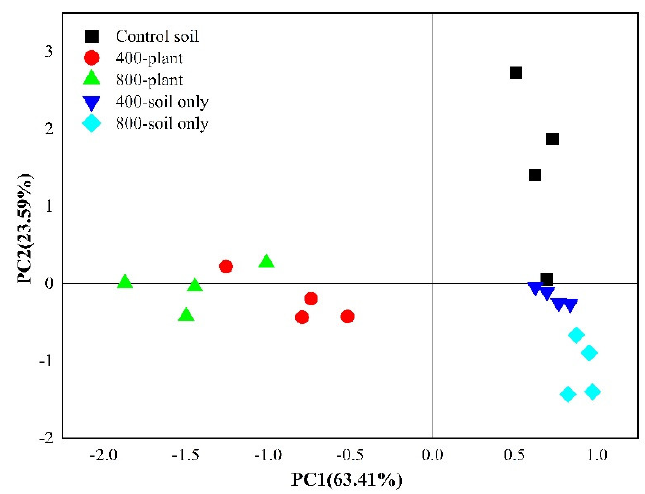
Figure 3. Principal component analysis of the PLFA composition of soil samples at the end of the 15−day labeling experiment. Values in parentheses on the axis labels indicate the percentage variation accounted for by each axis. 400:400 µmol·mol −1 CO 2 treatment; 800:800 µmol·mol −1 CO 2 treatment; the control soil is the original tomato soil.